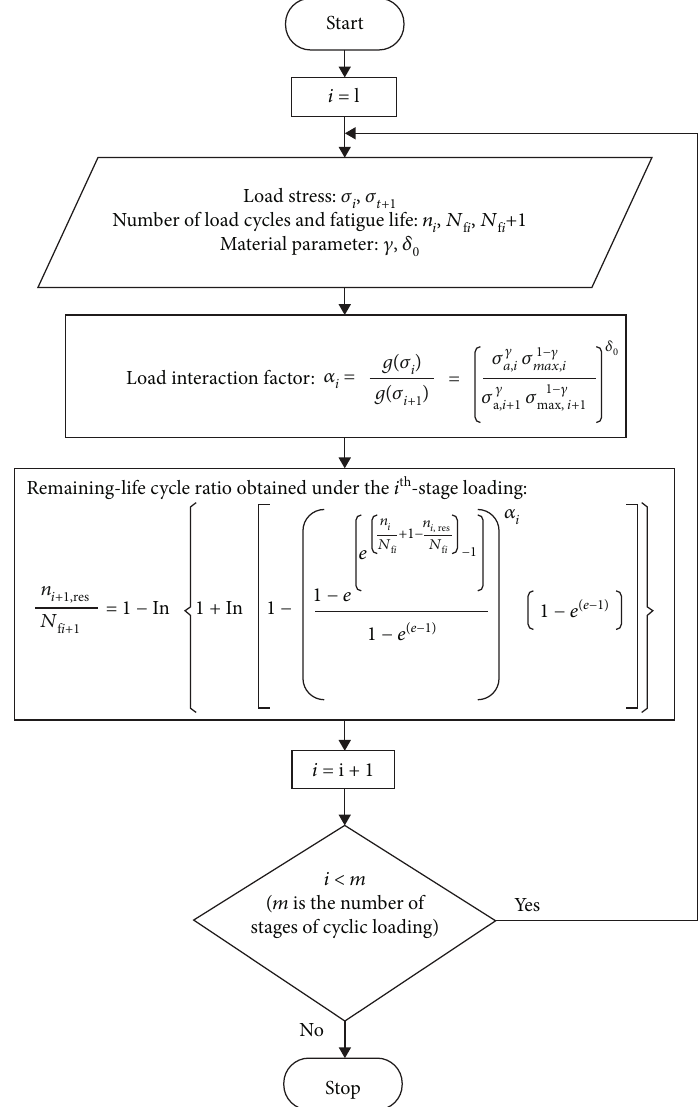
Figure 3: Flowchart of life prediction using the proposed